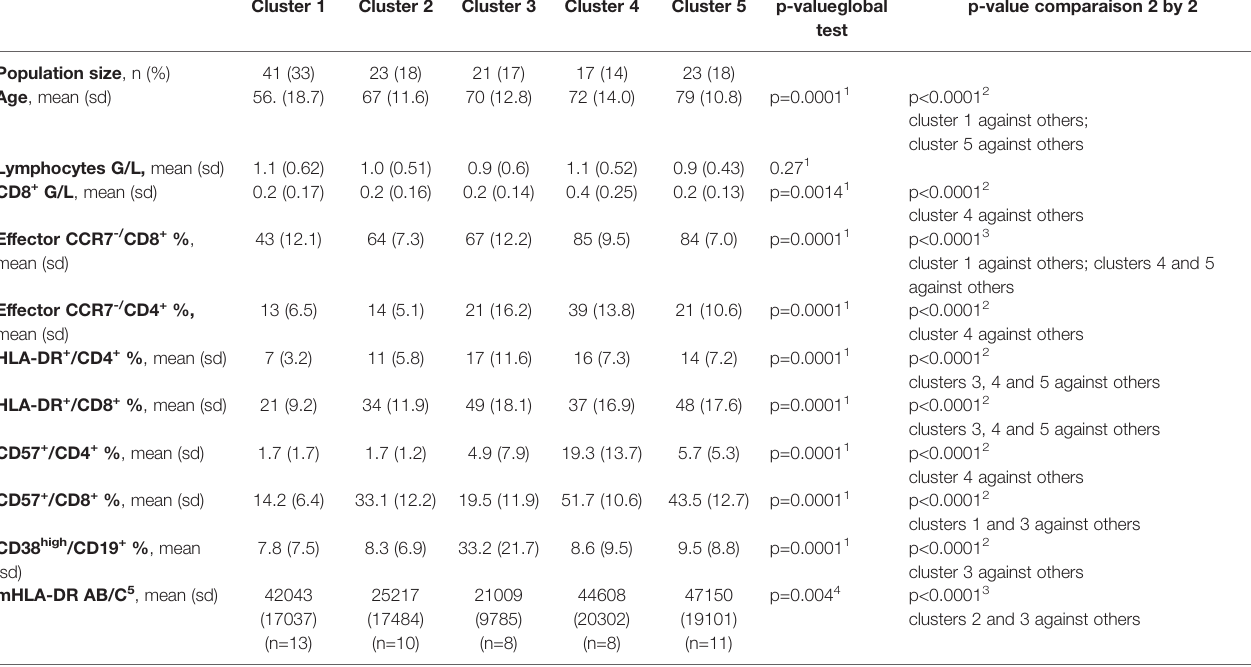
TABLE 4 | Clusters of SARS-CoV-2 infected patients based on immunophenotypic pro fi ling.